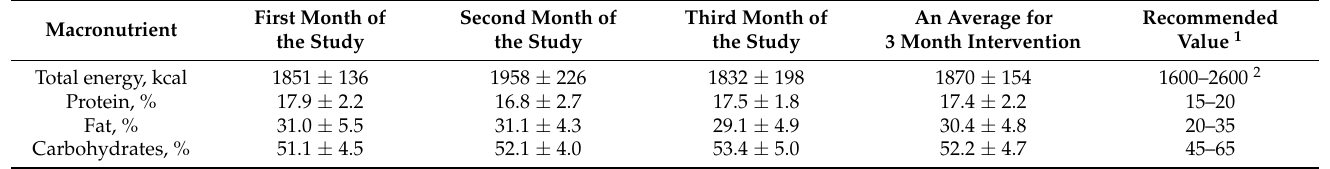
Table 1. Total energy and macronutrient distribution of the nursing home